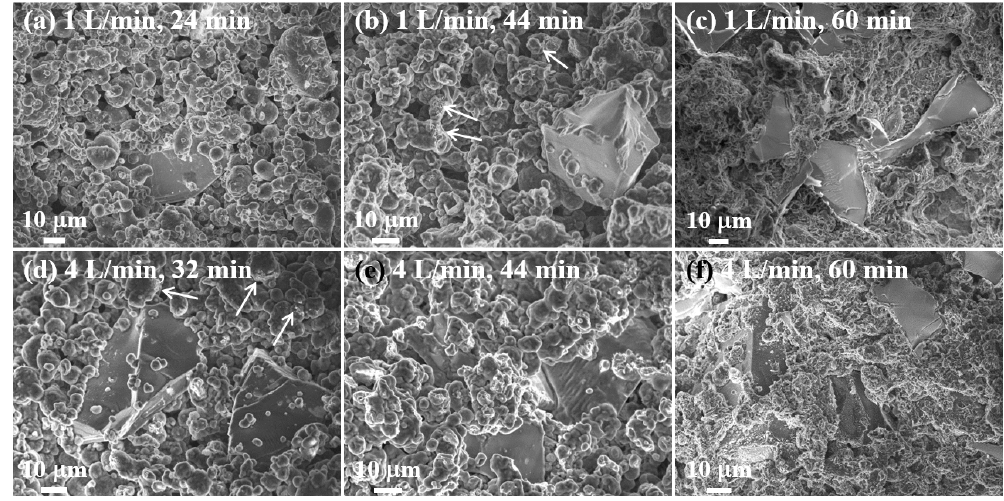
Figure 6. SEM images of 20 vol.% SiC (40 μ m)/Al 6061 composites in the powder bed after heating for various times at a set temperature of 640 °C under nitrogen flow rates of 1 L/min ( a – c ) and 4 L/min ( d–f ).